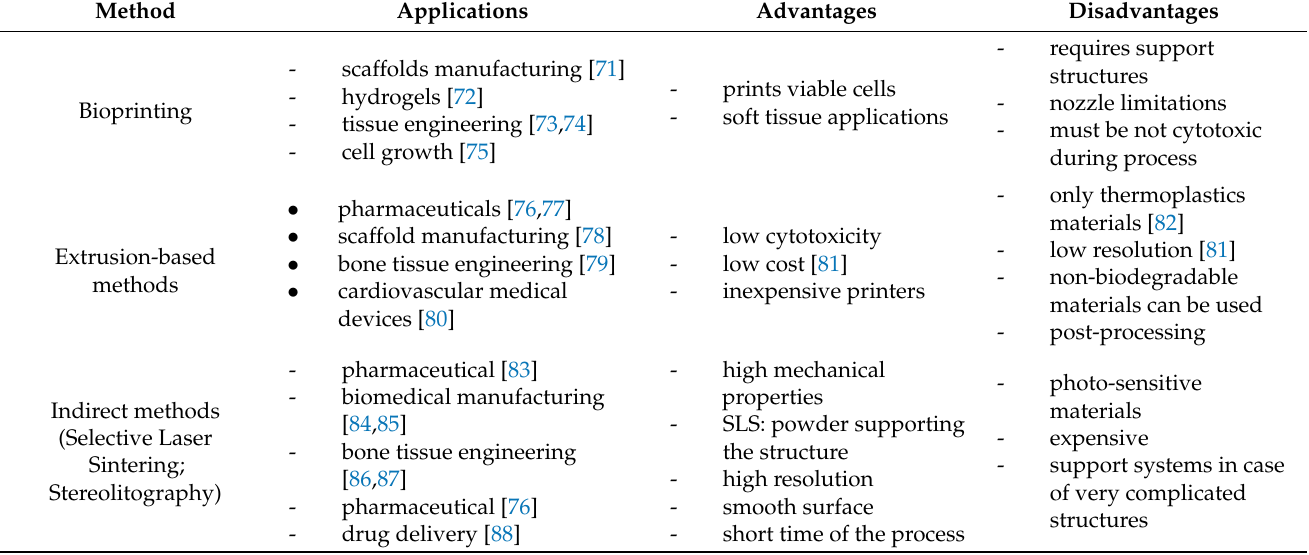
Table 2. The most popular 3D TE Scaffolds fabrication techniques—applications, advantages, and disadvantages.